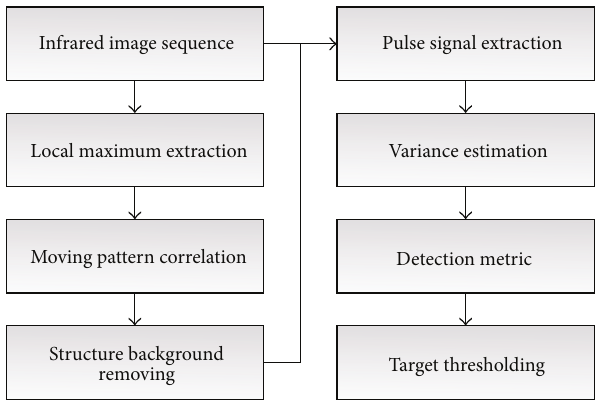
Figure 1: Execution of the proposed